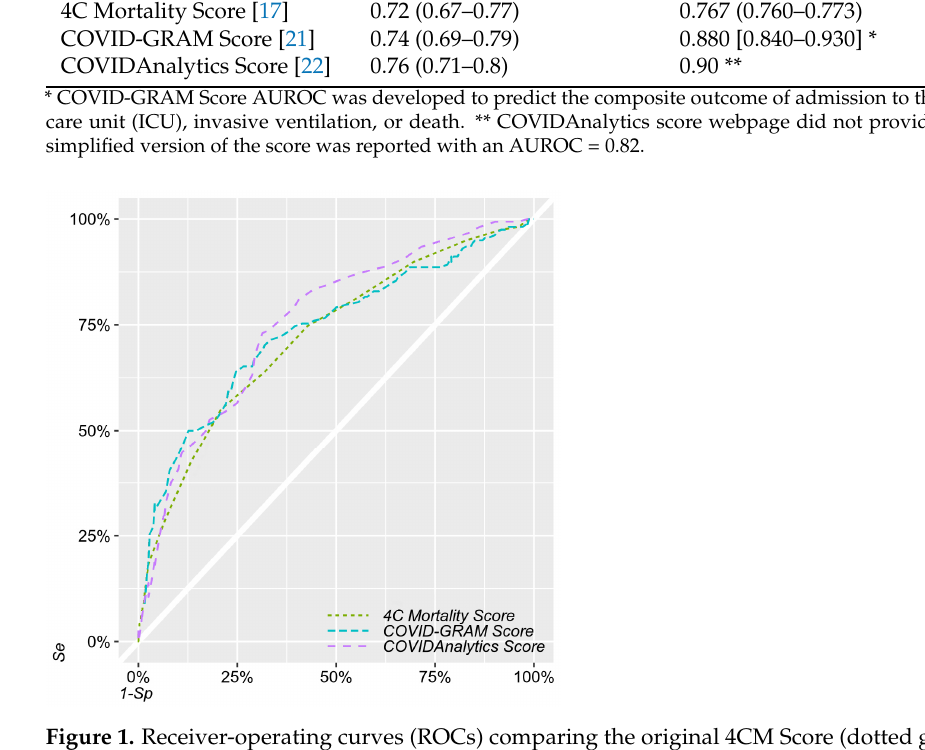
Figure 1. Receiver-operating curves (ROCs) comparing the original 4CM Score (dotted green line), COVID-GRAM (dashed blue), and COVIDAnalytics scores (dashed purple).